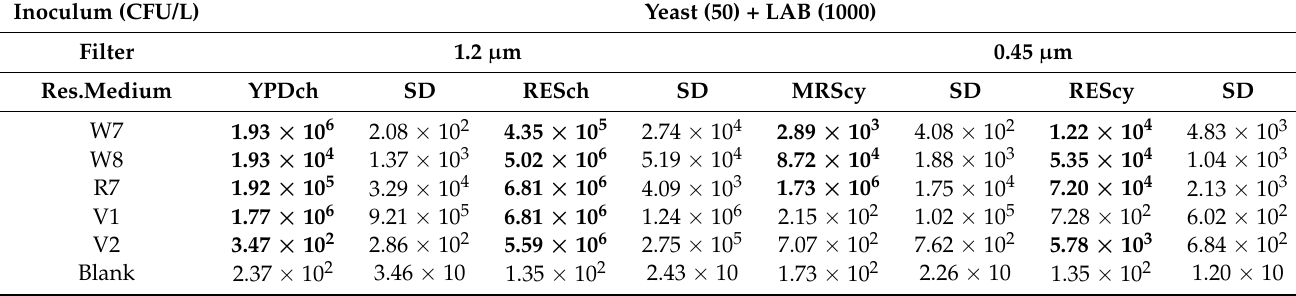
Table 5. Bioluminometer results on wines contaminated with the lowest microbial contamination indicated as acceptable by the producers for the tested wines. Sample RLU values 3 times higher than the blank RLU value indicate contamination (by yeasts when YPDch or RESch are used as resuscitation medium for 1.2 µ m filters, bacteria when MRScy or REScy are used to resuscitate cells on 0.45 µ m filters) and are indicated in bold. If the RLU value is between 2 and 3 times the blank, the result of the analysis is defined as uncertain. The medium is considered sterile if the RLU value is lower than 2 times the RLU of the blank (selective YDPch/RESch for yeasts, MRScy/REScy for bacteria). “W” stands for white wine, R for red wine, “V” for vermouth. All analyses were performed in triplicate, and the results are the mean of the 3 replicates ± standard deviation